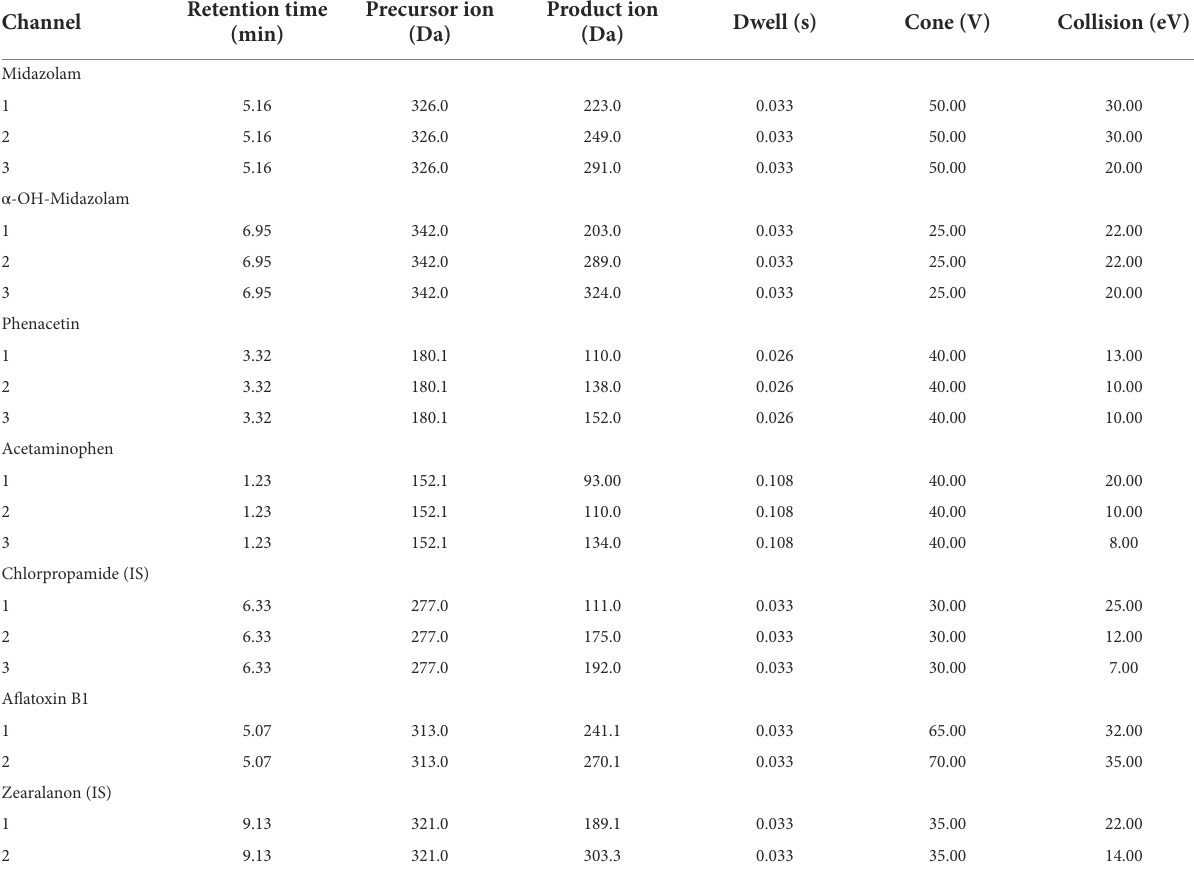
TABLE 2 Multiple reaction monitoring transitions and mass spectrometry settings for the CYP probes, aflatoxin B1 (AFB1) and internal standards